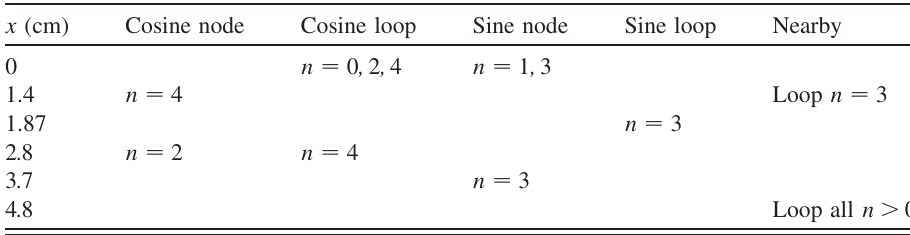
TABLE II. Nodes and loops of grating without sidewalls.